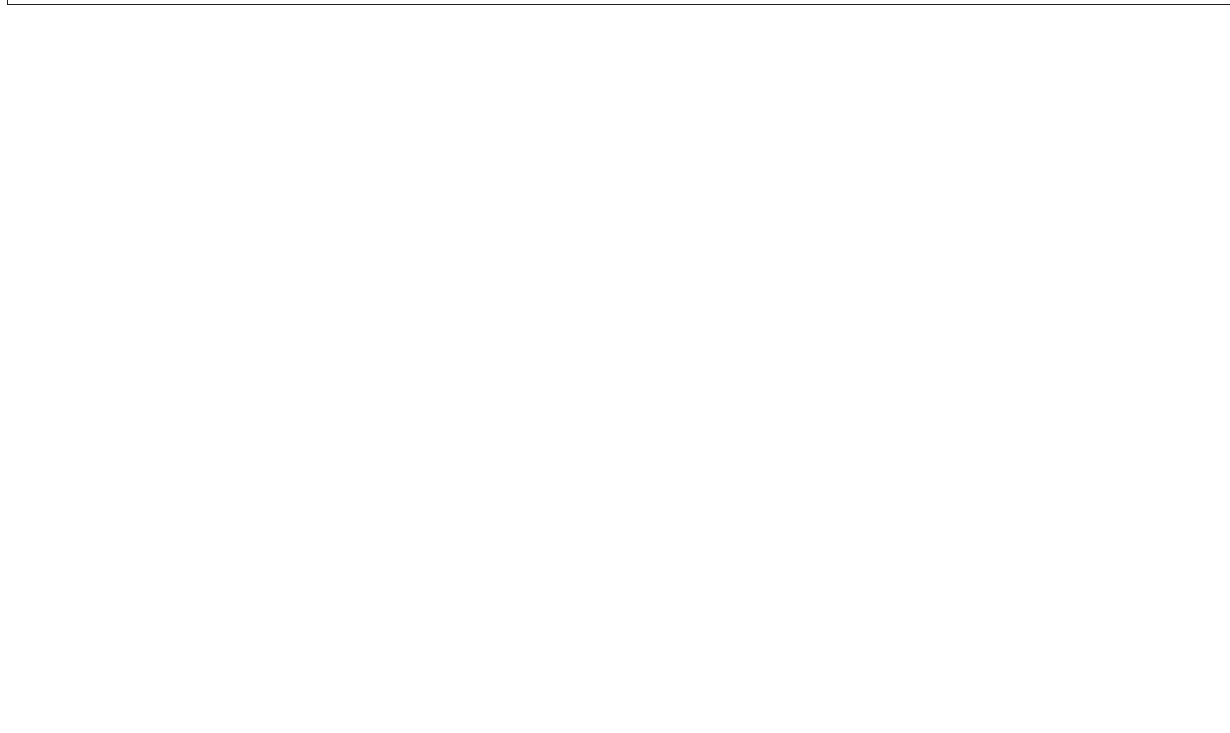
FIGURE 1 | Algorithm to predict and identify organoid differentiation, and real-time imaging modalities to monitor the metabolic status of the lamellar structure of ROs. This illustration is created by Biorender.com (A) OCT image, (B) HSpec image, and (C) FLIM image are reprinted with permission from ref (Browne et al., 2017). Copyright © 2017 Browne AW. et